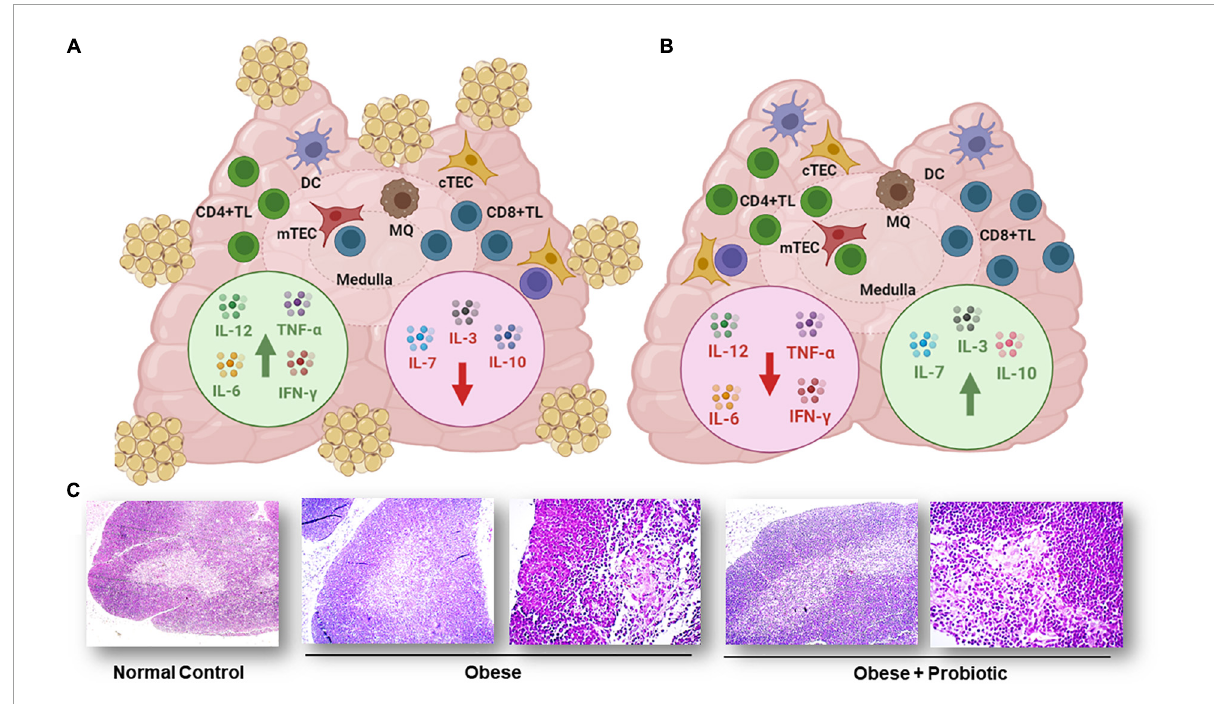
FIGURE5 Cytokine production in thymus of obese mouse model. (A) Thymus from obese animals showed adipose deposits covering the tissue, a significant decrease in thymocytes, increased levels of IL-12, IL-6, TNF- α , and IFN- γ (green arrow) and decreased production of IL-3, IL-7, and IL-10 (red arrow). (B) Thymus from obese mice fed probiotic bacteria L. casei CRL 431 did not exhibit visible adipocytes, recovered thymocyte numbers, showed decreased levels of IL-12, IL-6, TNF- α , and IFN- γ (red arrow), and exhibited increased levels of IL-3, IL-7, and IL-10 (green arrow). Cytokines were measured by ELISA in the supernatants of cultured thymocytes. Figure created with BioRender.com, based on data from Balcells et al. (206). (C) Micrographs of thymus sections from normal control and obese mice. Tissue sections from normal control (100 × ), obese control (100 × and 400 × ) and obese mice feed with probiotic bacteria (100 × and 400 × ) stained with hematoxylin and eosin. Figure modified from Balcells et al.